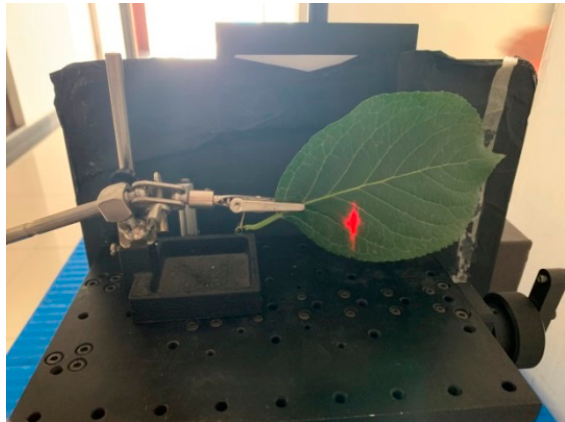
Figure 10. Spectral profiles collection in the lab.